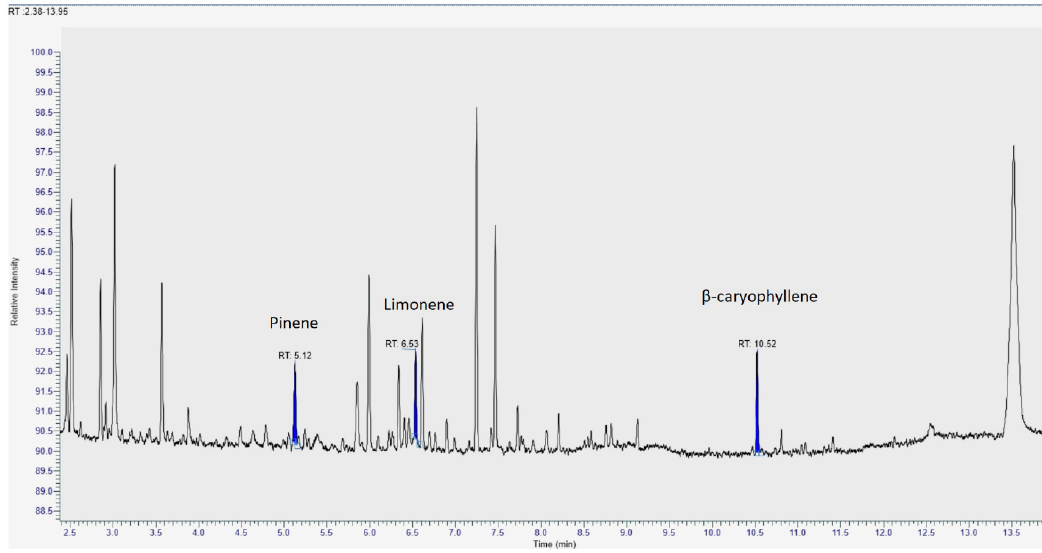
Figure 3. Representative GC/MS chromatograms of the extracts obtained from medical Cannabis.